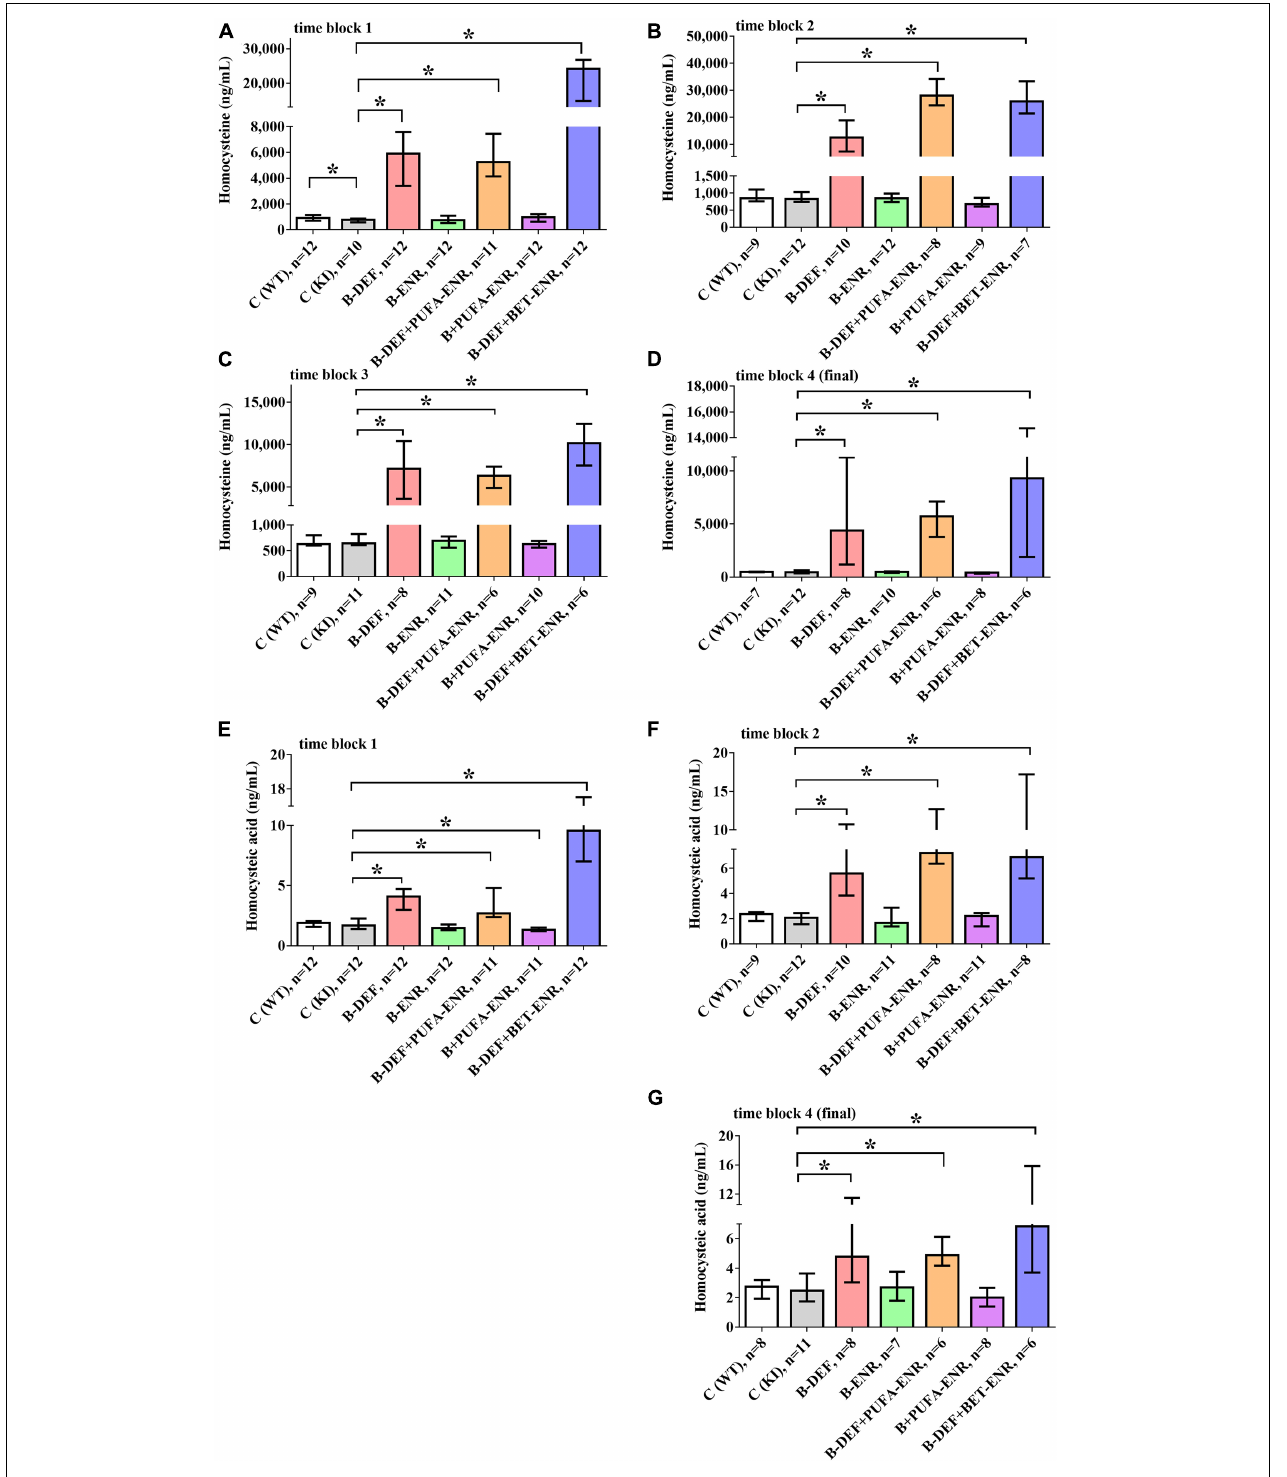
FIGURE 3 | In vivo serum levels of homocysteine (HCys) and homocysteic acid (HCA); (A) HCys, time block 1; (B) HCys, time block 2; (C) HCys, time block 3; (D) HCys, final sampling step; (E) HCA, time block 1; (F) HCA, time block 2; (G) HCA, final sampling step; no data obtained for homocysteic acid in time block 3 due to sample loss while sample preparation; all samples analyzed via LC-MS/MS; median ± IQR; outliers beyond 3-fold IQR removed; p < 0.05 (Mann-Whitney- U -test) considered statistically significant (*).